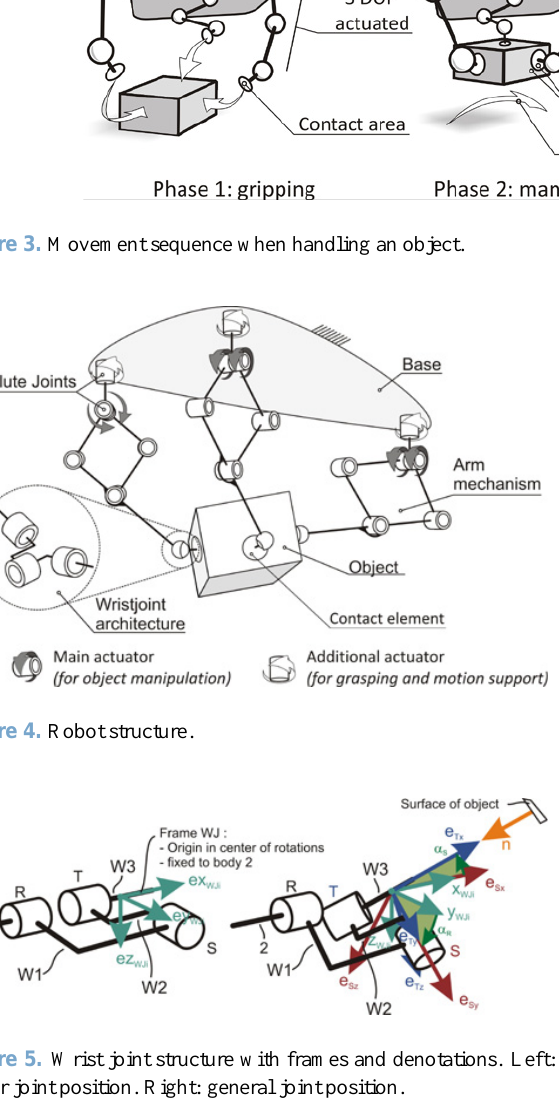
Figure 7. Wrist joint test